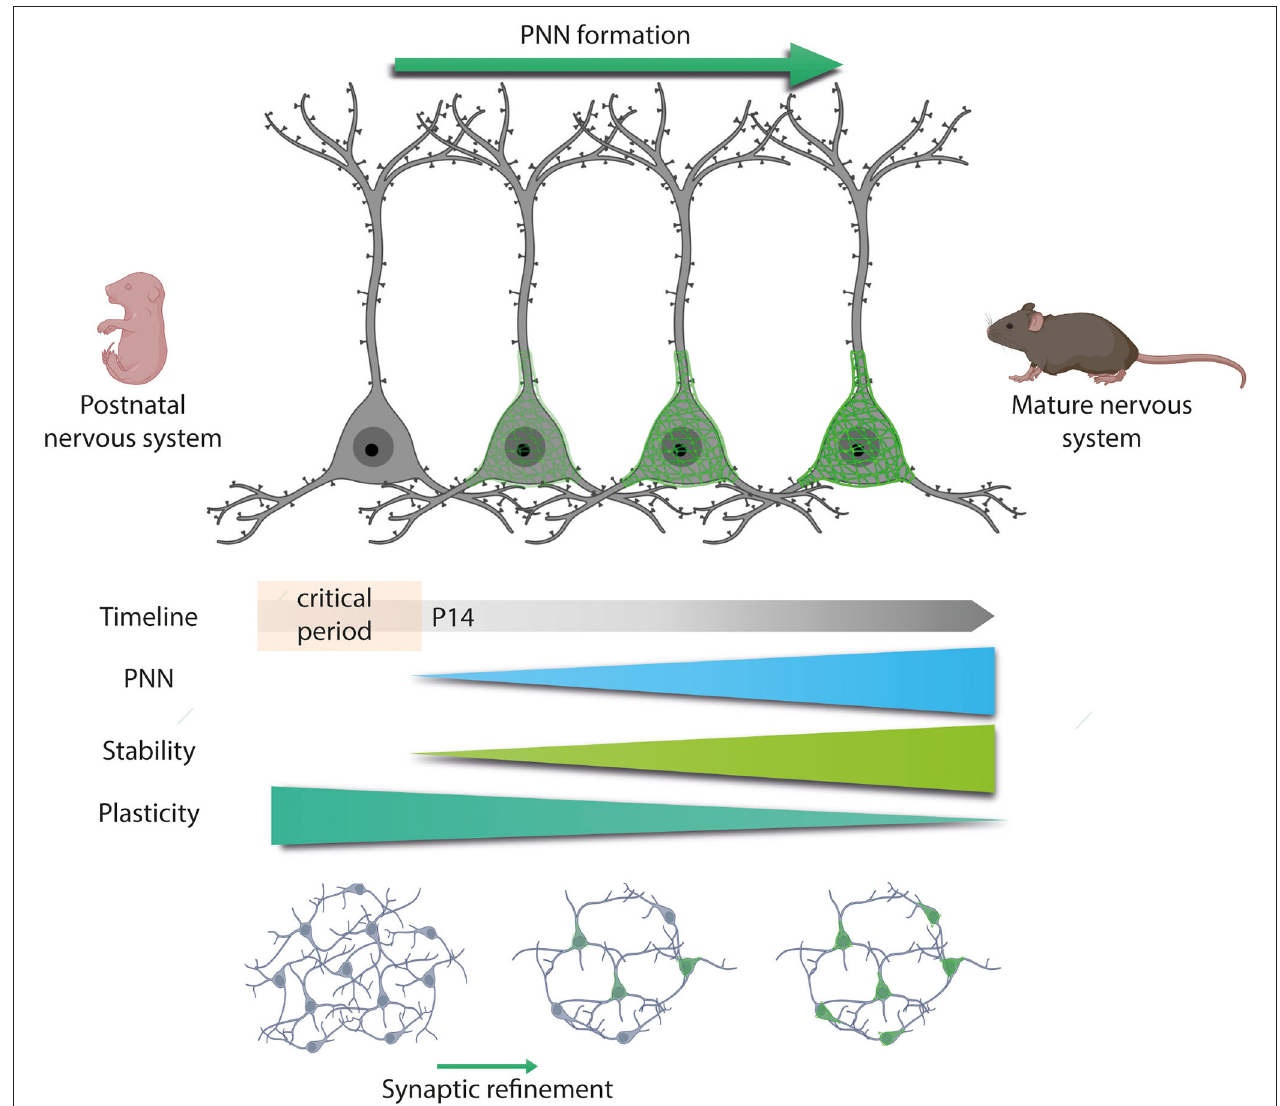
FIGURE 3 | Developmental PNNs formation. PNNs first appear during development, specifically at the end of the critical period, P14 in the spinal cord. The critical period is a plastic phase in which neurons increased their activity and generate new synaptic contacts. Once PNNs appear, they would wrap active neurons and stabilize these new connections formed. However, the absence of PNNs around unused synapses would lead to their pruning. Thus, as long as PNNs are formed, the plasticity of the central nervous system (CNS) decreases while stability